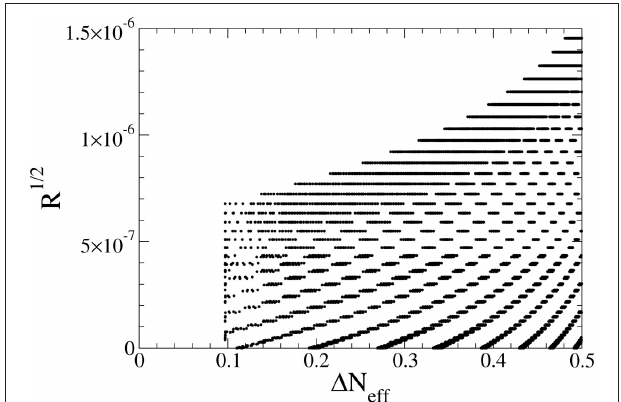
FIGURE 11 | R 1 / 2 against 1 N eff with m η where m η 0 is varied between 221 and 227 GeV, and R I ˆ B ( τ → e γ ) / ˆ B ( µ → e γ